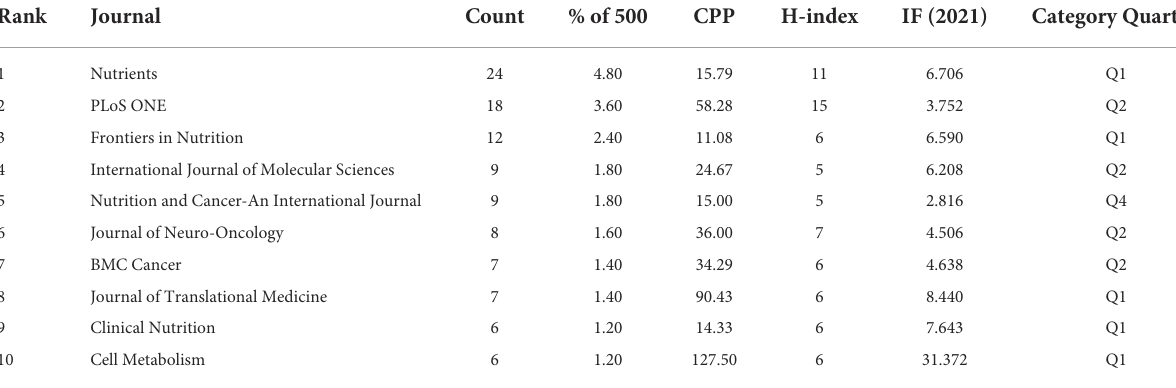
TABLE 4 The top 10 scholarly journals in the field of ketogenic diet on cancer research.